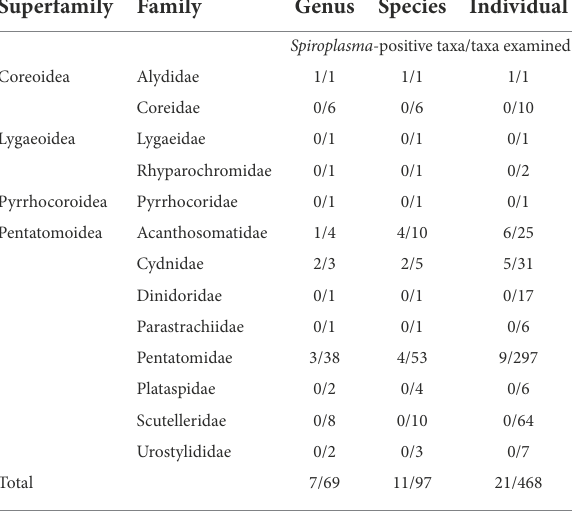
TABLE 1 Summary of Spiroplasma detection from diverse stinkbugs representing 4 superfamilies, 13 families, 69 genera, 97 species and 468